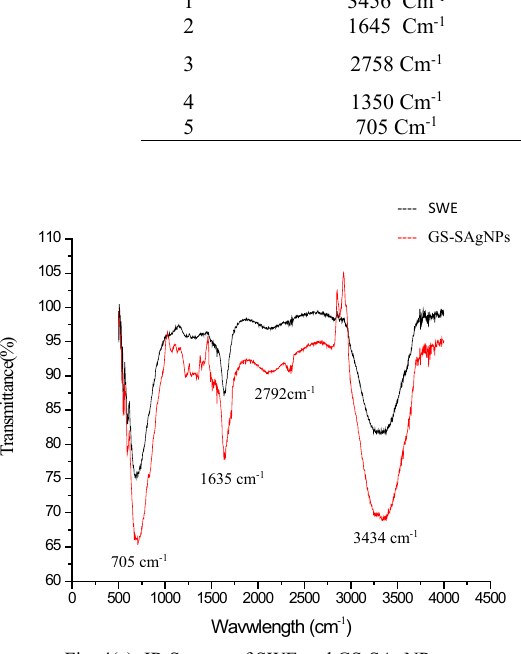
Fig. 4(a): IR Spectra of SWE and GS-SAgNPs